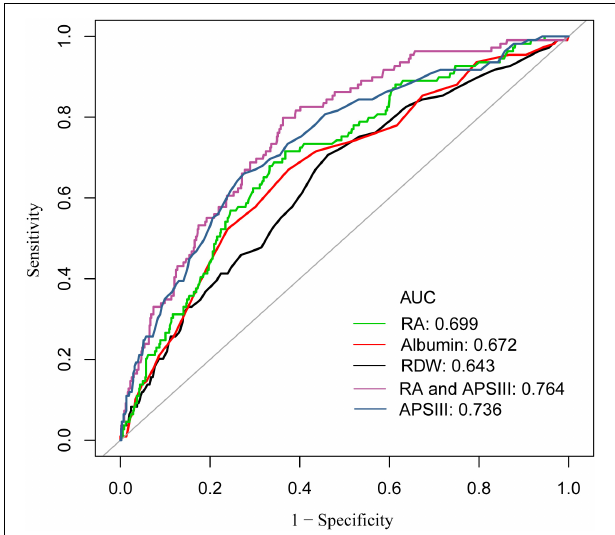
FIGURE 4 | Receiver operator characteristic (ROC) curve analysis for 90-day mortality of patients with coronary heart disease, who have undergone PCI. AUC, area under the curve; RA, the ratio of red cell volume distribution width to albumin; RDW, red cell distribution width; APSIII, acute physiology score III.